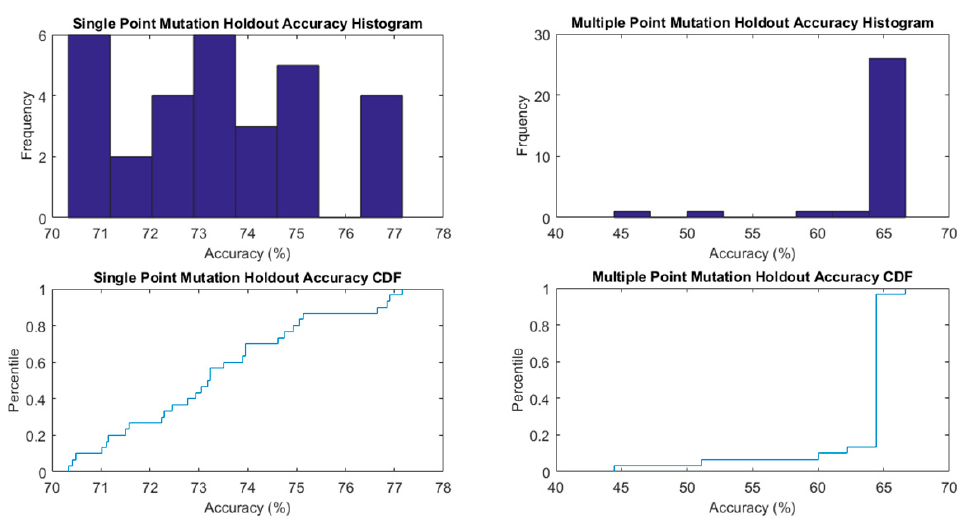
Figure 4. Single Point and Multiple Point Mutation Holdout Random Sampler Accuracy on Testing subset cumulative distributions and frequency histograms.